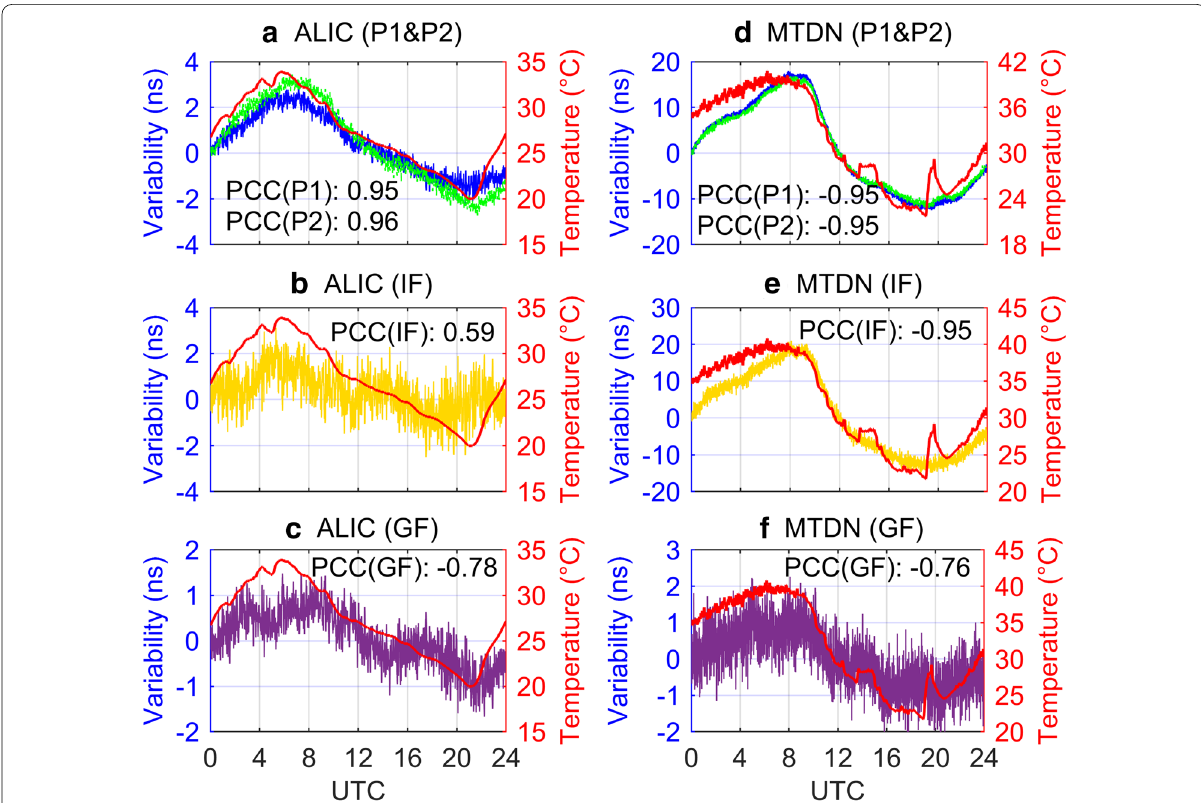
Fig. 1 Time-varying of P1 (blue lines) and P2 (green lines) receiver code biases of ALIC (left column) and MTDN (right column) on day 002 in 2017 and day 005 in 2018, respectively, as estimated by the MPPP, and their ionosphere-free (gold lines) and GF (purple lines) combinations. The red lines depict intraday temperature